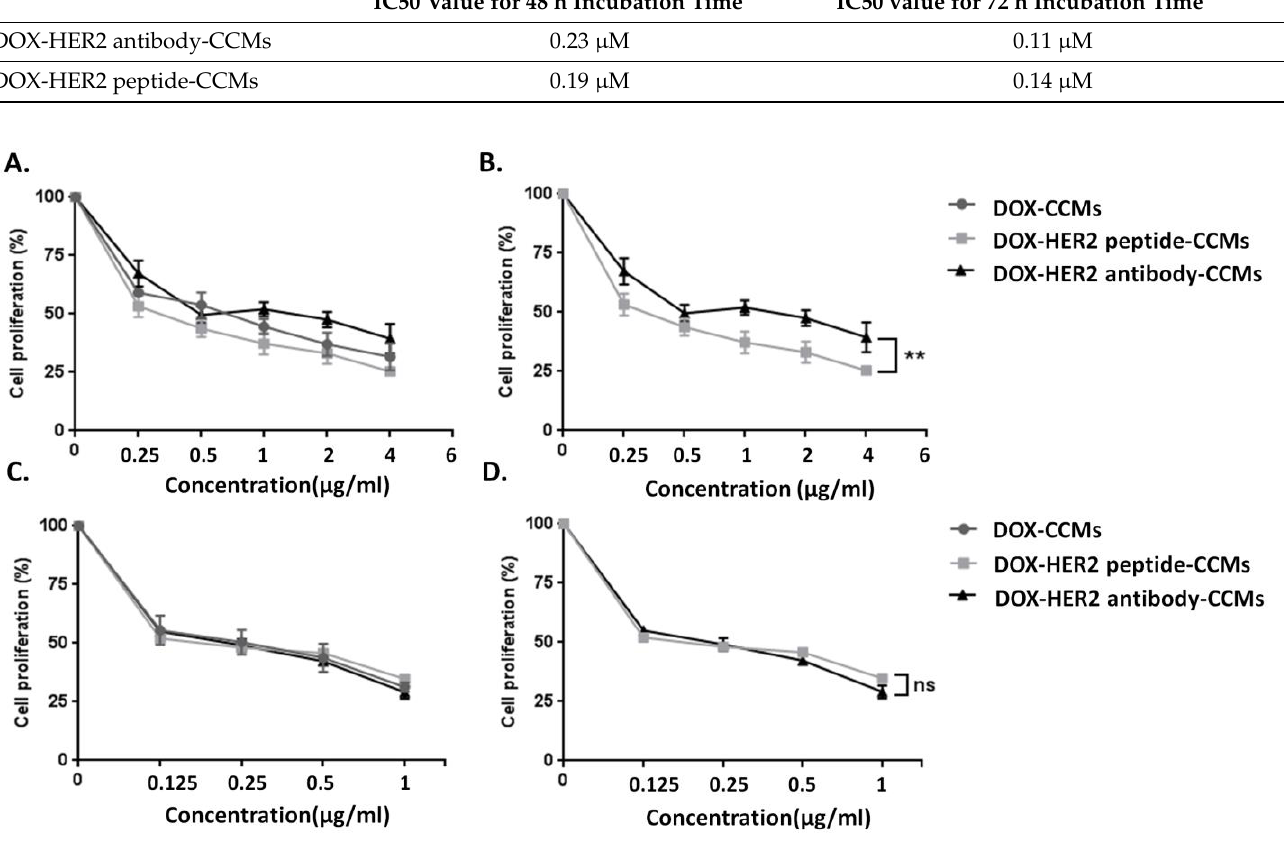
Table 2. Summary of the IC50 values of DOX-CCMs, DOX-HER2 peptide-CCMs, and DOX-HER2 antibody-CCMs on SKBR-3 and MCF-10A for 48 and 72 h incubation time.